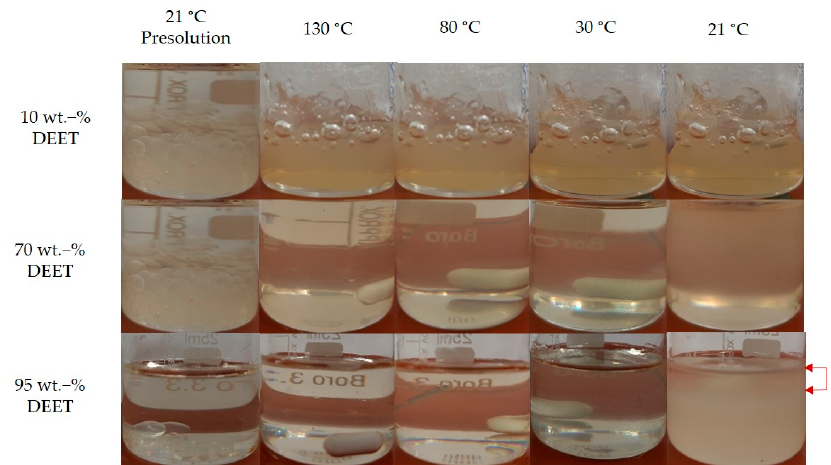
Figure 1. DEET-PDLLA samples with 10, 70, and 95 wt.-% DEET at varying temperatures during cooling.